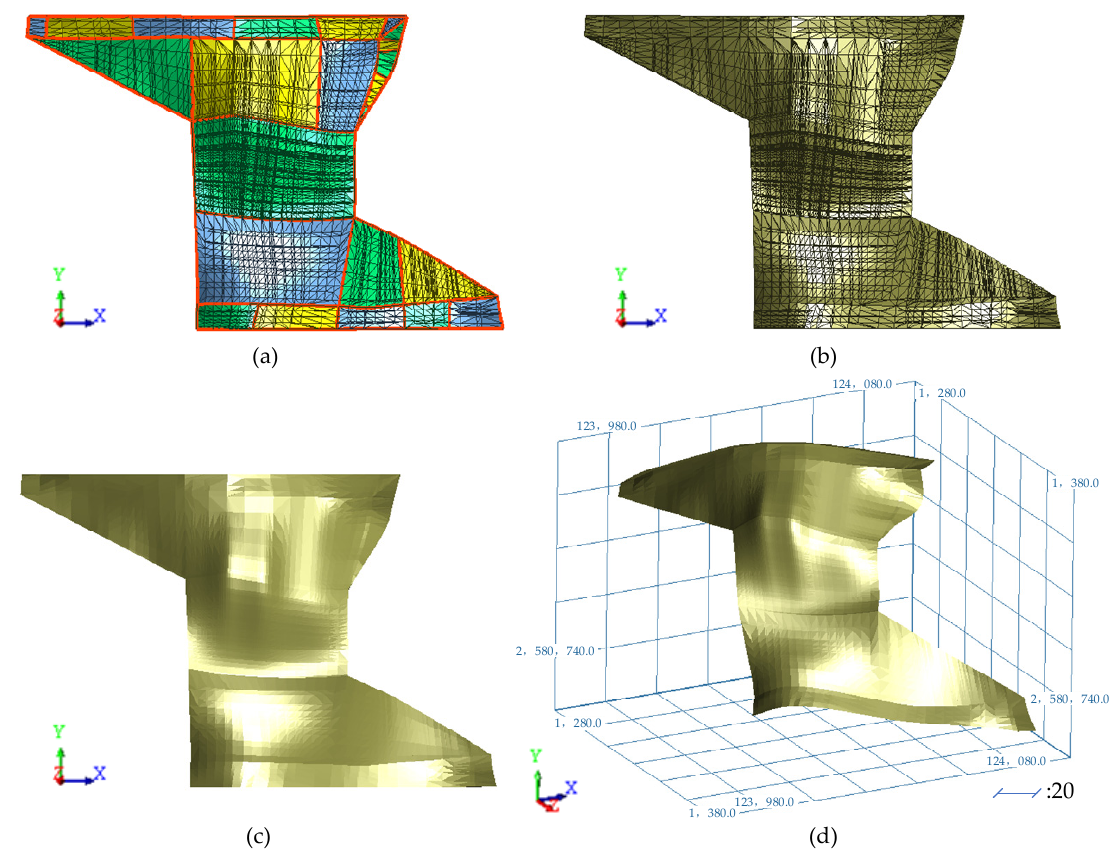
Figure 11. Schematic diagram of the sub-mesh combination: ( a ) the sub-meshes; ( b – d ) the complete model.